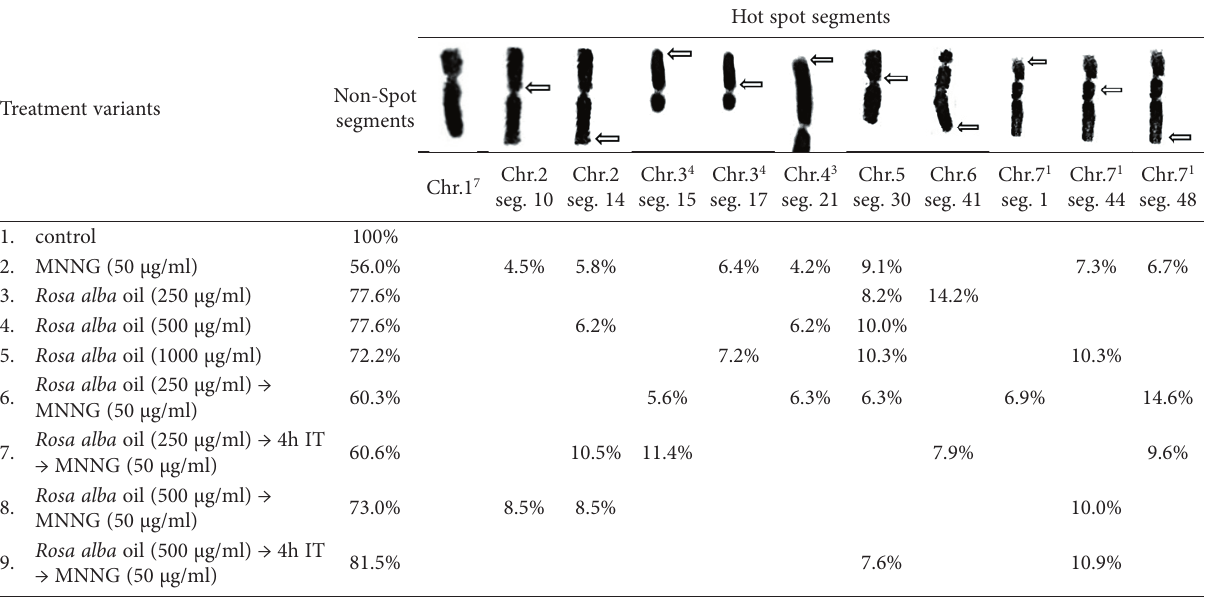
Table 2. Observed aberration “hot spots” in chromosomes of barley root tip meristem cells of the reconstructed karyotype MK14/2034 after different treatment procedures